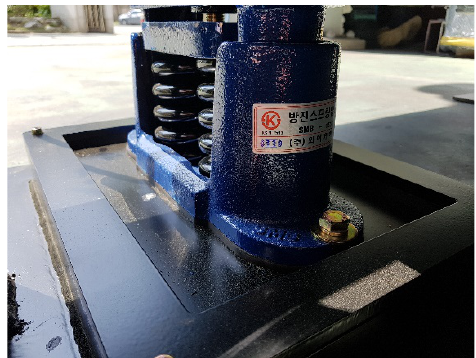
Figure 5. Proto-type of simplified mount module. (Korean label denotes manufacturer of spring component, YJ Industrial Co., Ltd./South Korea, Gyeonggi-do).